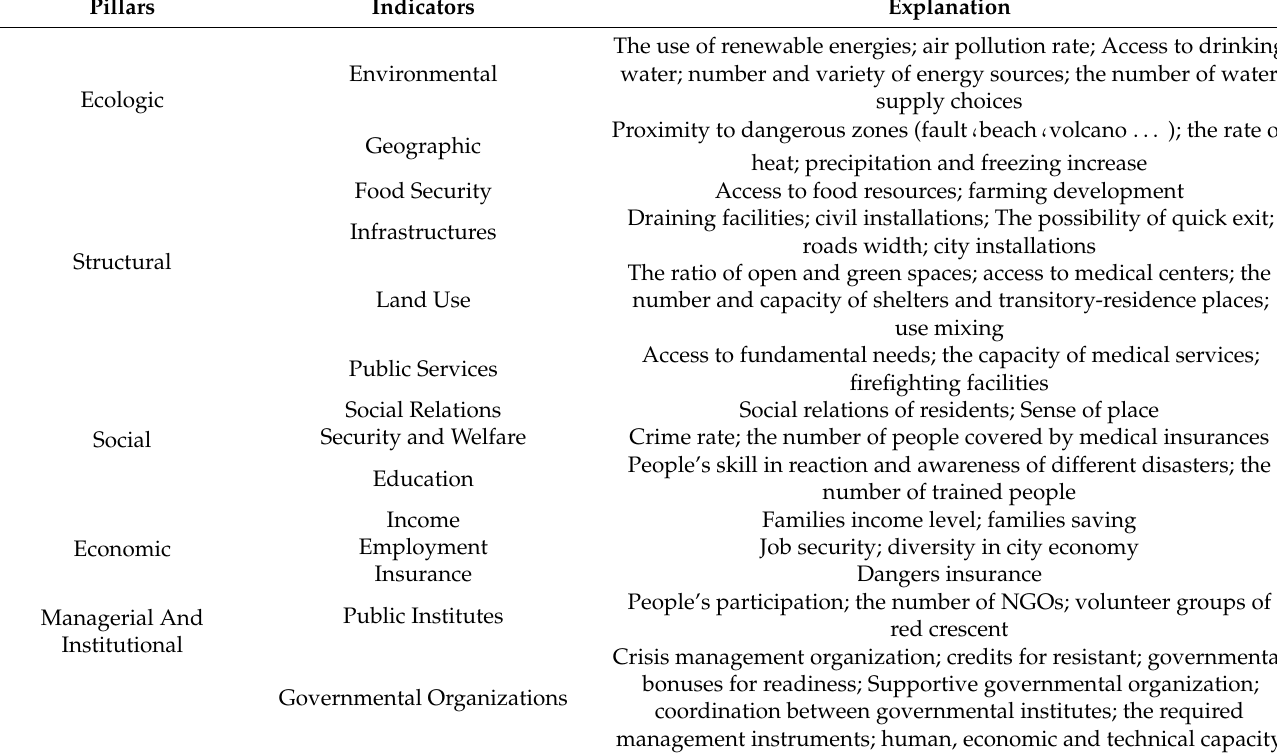
Table 1. Indexes used for the evaluation of city resilience [5,17,35–37].